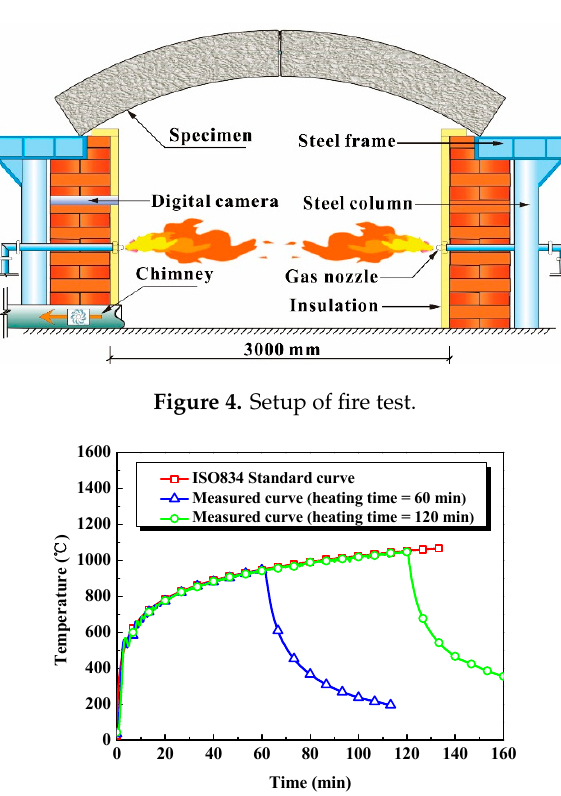
Figure 5. Measured temperature-time curves in the furnace chamber.